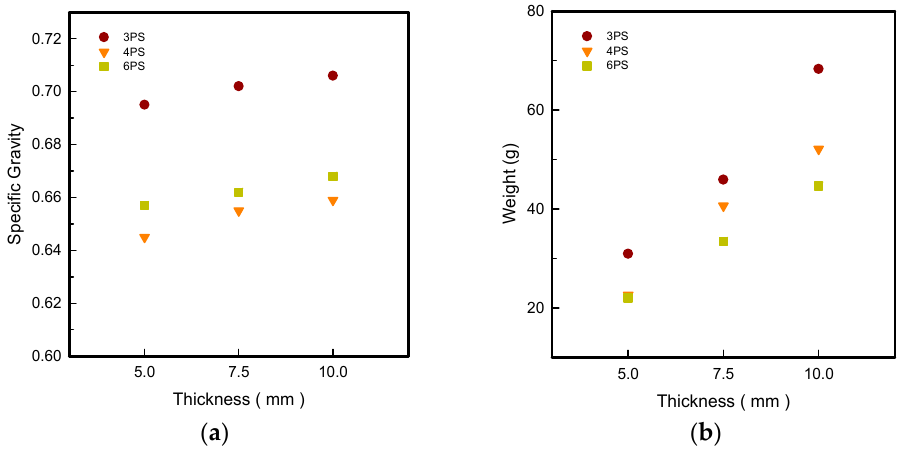
Figure 1. Specific gravity ( a ) and weight ( b ) of the LW 3DP 3-, 4-, and 6-SP outsole with various thicknesses.